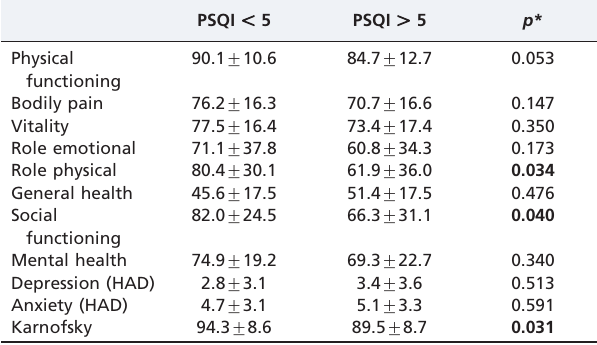
Table 4 - Relationship between HRQoL and sleep quality after renal